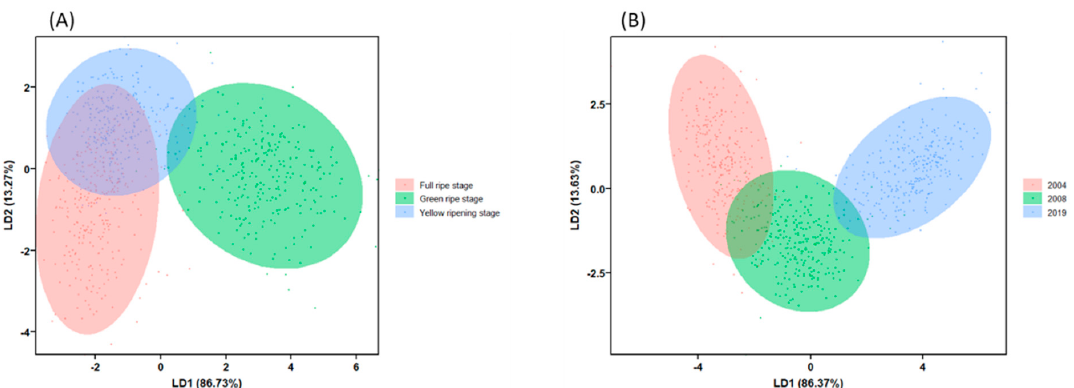
Figure 5 . Principal component analysis based on multispectral data of alfalfa seeds of ( A ) different maturity levels and ( B ) harvest years.